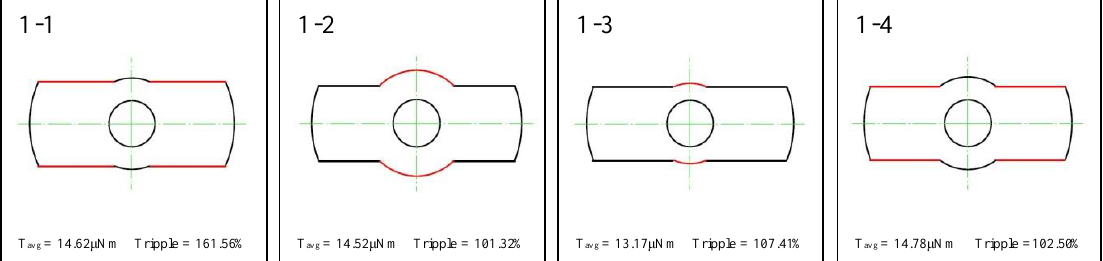
Figure 3. Step 1: Design process of the rotor magnetic pole width and root diameter.